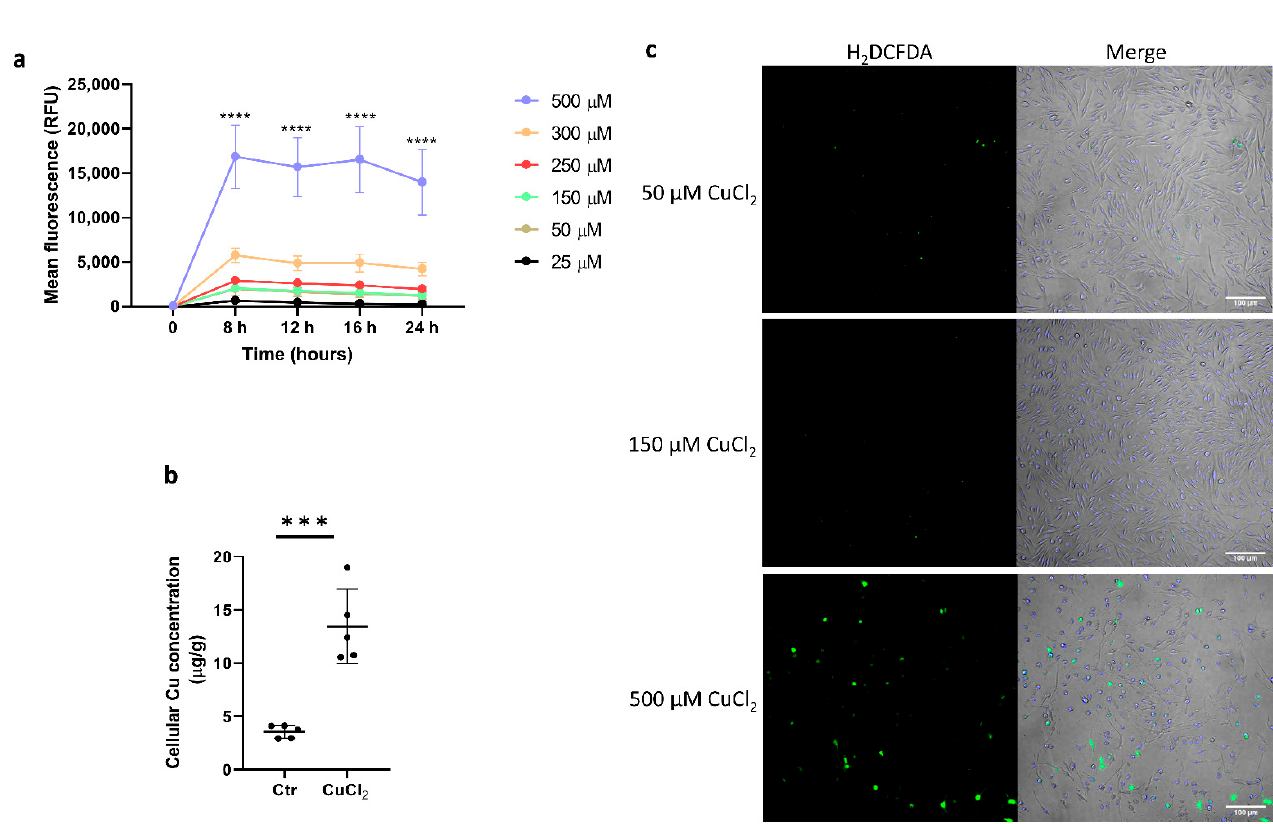
Figure 1. CuCl 2 toxicity and ROS production in BMDMs. ( a ) Cytotoxic effect of CuCl 2 treatment on BMDMs was measured in time (8–24 h) and dose (25–500 μ M)-dependent manner. Fluorescence signal (RFU) produced by the dye binding to the dead-cell DNA is proportional to cytotoxicity. Ex: 485nm, Em: 520nm. Data were normalized to values obtained for non-treated control cells. Results are presented as mean ± SD, **** p < 0.0001. ( b ) Cellular copper concentration in BMDMs was determined by ICP-MS after 16 h incubation with 150 μ M CuCl 2 . Data are presented as mean ± SD, *** p < 0.001. ( c ) ROS production: confocal images of BMDMs treated with 50, 150, and 500 μ M CuCl 2 loaded with 5 μ M of ROS probe H 2 DCFDA. Hoechst was used as nucleus stain. Scale bar: 100 μ m.